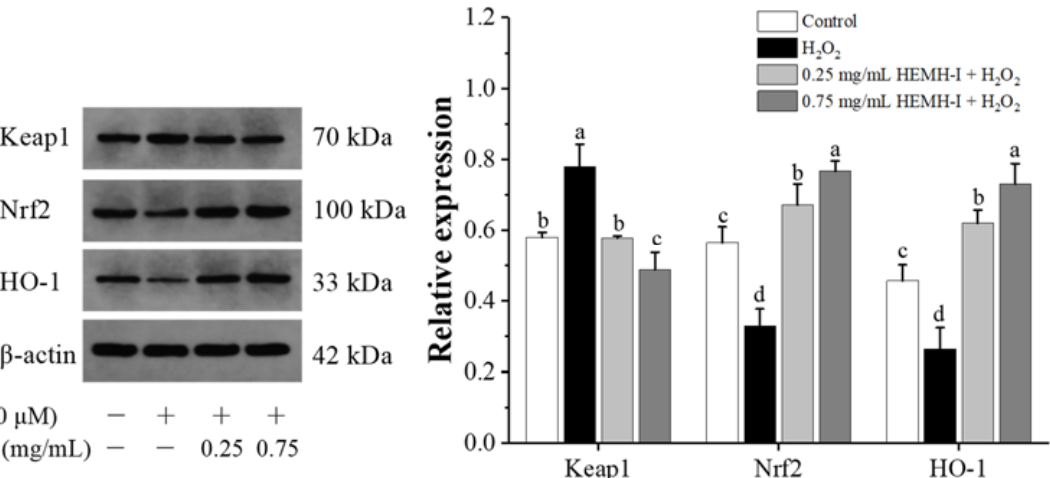
Figure 9. Effect of HEMH-I on the expression of Keaps1, Nrf2, and the downstream antioxidant enzyme HO-1 in SW1353 human chondrocytes. Values are expressed as mean ± SD ( n = 3). Means annotated with different letters (a–d) for the same parameter are significantly different ( p < 0.05).